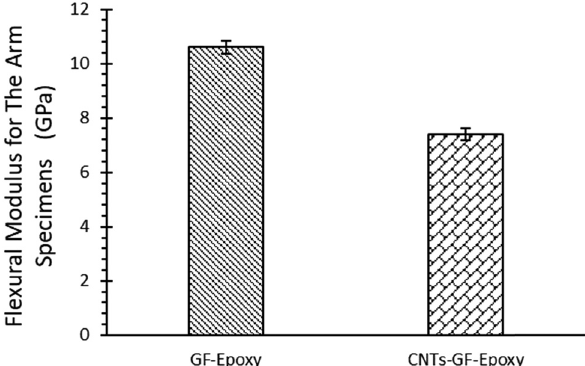
Figure 11: Comparison of fl exural modulus for the arm DCB